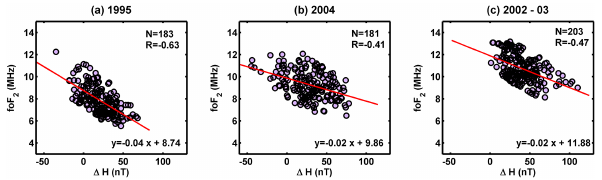
Figure 7. Scatter plot of (cid:49)H vs. f o F 2 showing relationship be- tween these parameters in (a) 1995, (b) 2004 and (c)